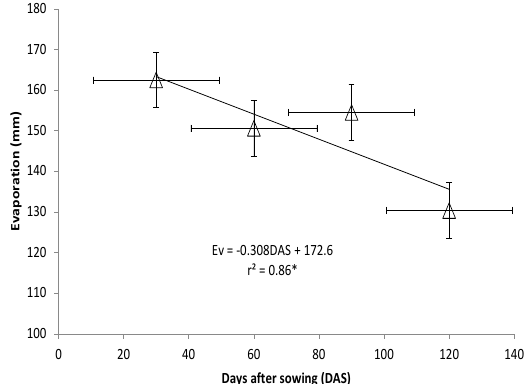
0.96**K K (witness) = -0.00007DAS 2 + 0.0138DAS + 1E-15 r² = Figure 4. Light attenuation coefficient (K), in sunflower ( Helianthus annuus L.) under three potassium levels at 30, 60, 90 and 120 days after sowing. Universidad Tecnológica de Tehuacán. Summer, 2017. DAS, days after sowing.